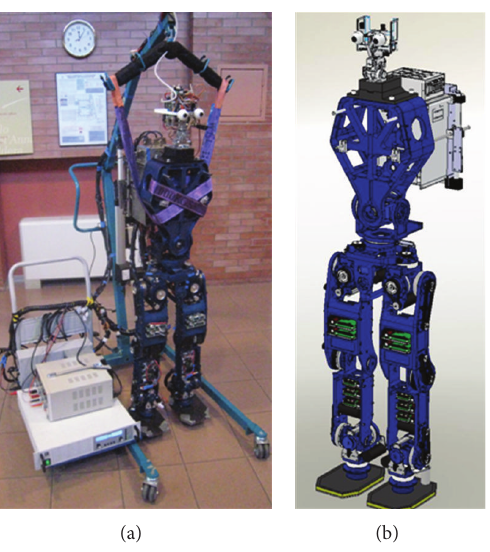
Figure 5: SABIAN humanoid